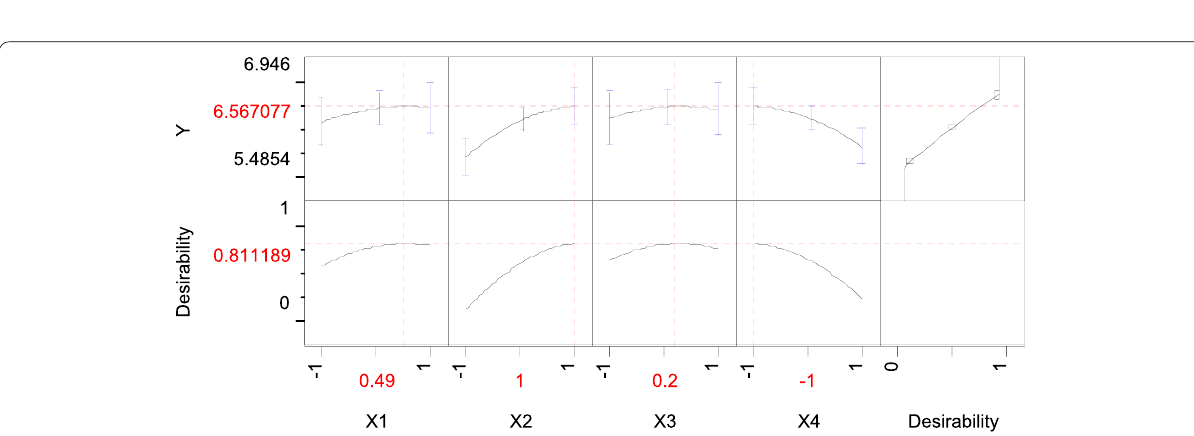
Fig. 5 JMP desirability prediction profile showing the predicted optimal coded levels (0.4555, 1, 0.35166 and starch, NH 4 NO 3 and FeSO 4 .7H 2 O, respectively, to maximize the CHO by Streptomyces sp.